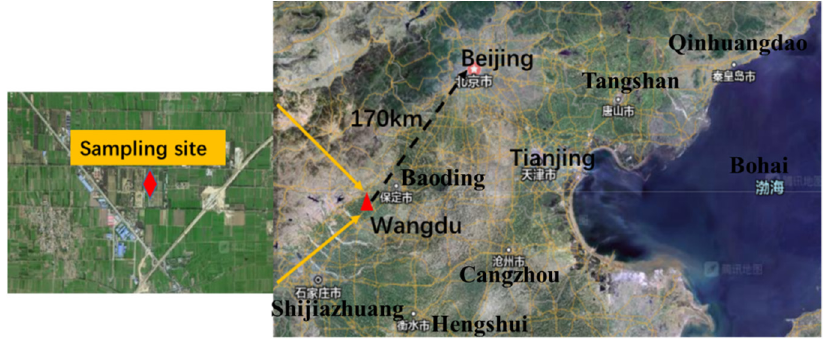
Figure 1. Field measurement site in Wangdu, Hebei Province.